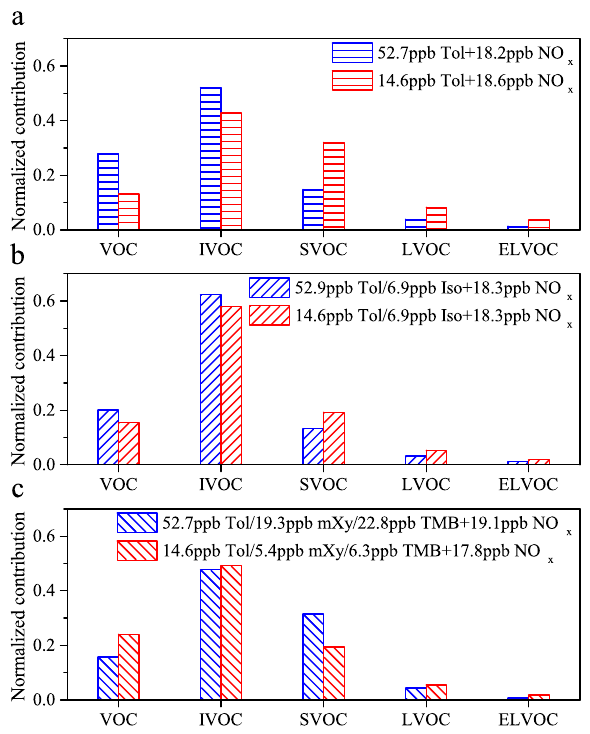
Fig. 5 Normalized contributions of different classes of gas-phase organic intermediates. Contributions of different classes of gas- phase organic intermediates (i.e., VOC, IVOC, SVOC, LVOC, and ELVOC) formed from photo-oxidation under different mixed VOC scenarios in the presence of NO x (~20 ppb) at higher and lower VOC concentration levels. a toluene, b mixed toluene and isoprene, as well as c mixed toluene, m-xylene, and